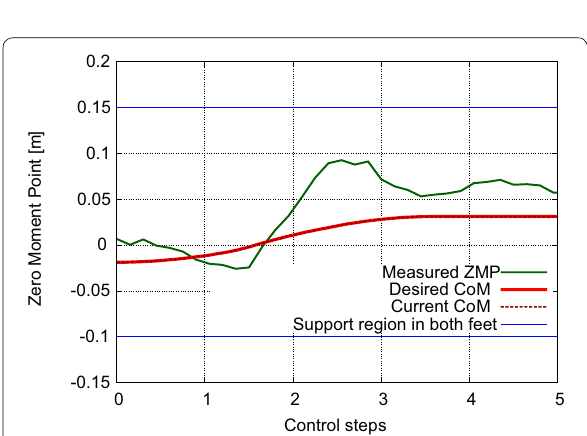
Fig. 10 Comparison of the calculation times. In the control steps 10 to 30, the conventional method calculates the joint angles rapidly because the robot’s pose is similar to the initial pose